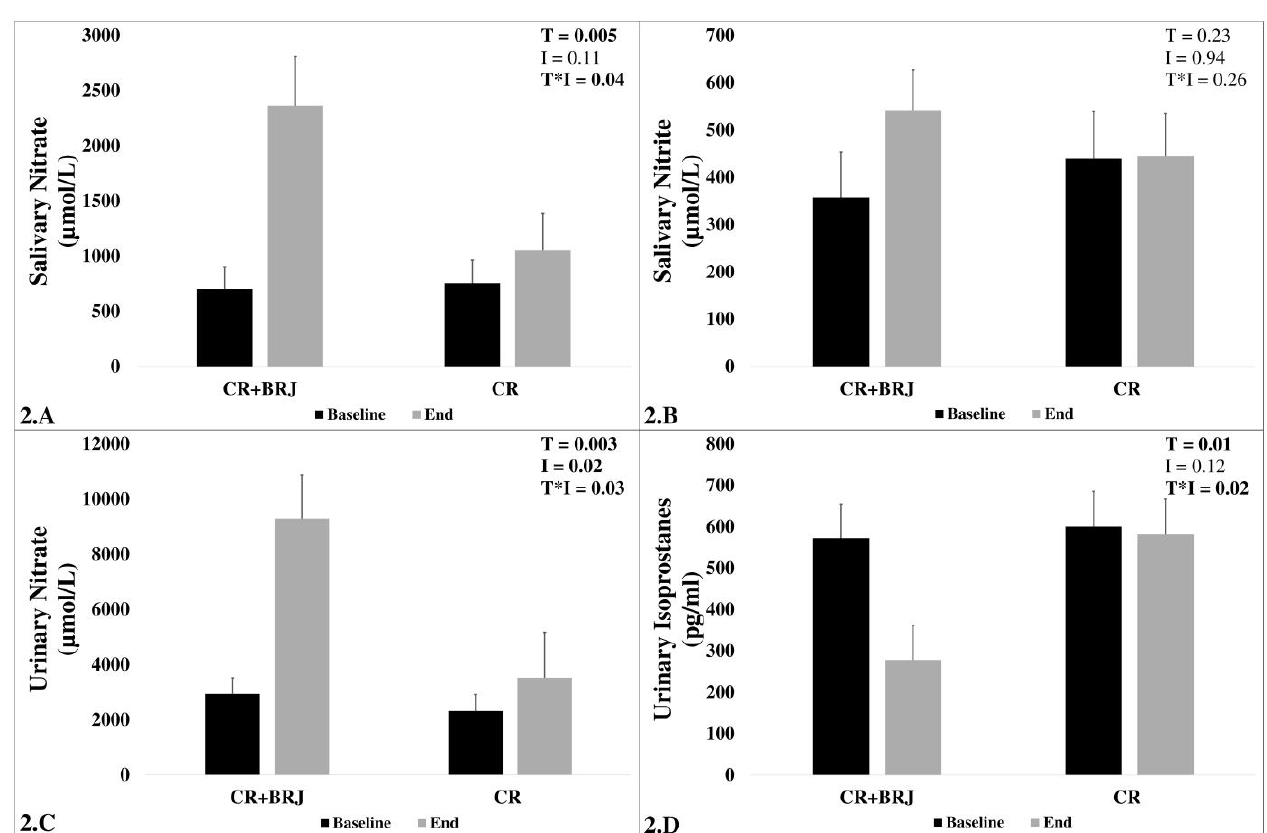
Figure 2. The effect of the interventions (CR + BRJ and CR) on the concentrations of salivary nitrate ( A ), salivary nitrite ( B ), urinary nitrate ( C ), and salivary isoprostanes ( D ) at the two-time points (baseline and end) among overweight and obese, middle-aged and older adults. Key: CI, confidence interval; CR, caloric restriction; CR + BRJ, caloric restriction with beetroot juice; I, intervention; p , p - value; T, time; T*I, time*intervention.